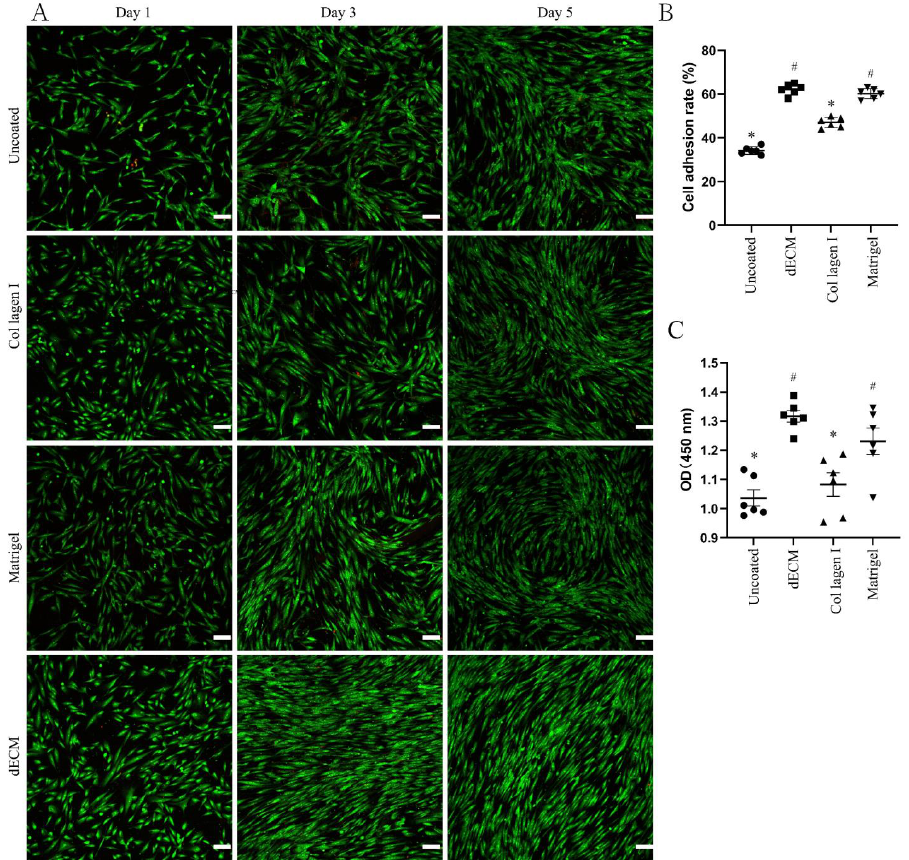
Figure 2. Characteristics of the decellularized extracellular matrix hydrogel derived from cultures of decellularized porcine heart aortic scaffolds. Live/dead staining of ( A ) CD31+ HemECs cultured on different hydrogels on days 1, 3, and 5. The cell adhesion rate of ( B ) CD31+ HemECs on different hydrogels at 10 min after cell seeding. The proliferation rate of ( C ) CD31+ HemECs on different hydrogels at 24 h after cell seeding. * p < 0.05 versus the ECM group; # p < 0.05 versus the untreated group. Scale bar = 100 μm.